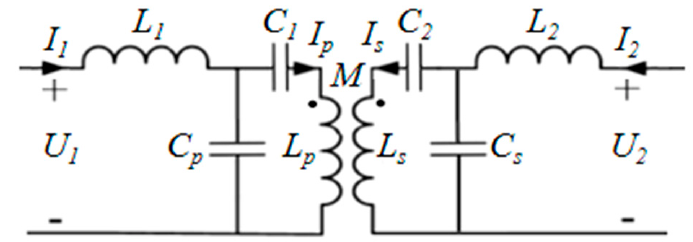
Figure 17. Dual-LCC compensation.